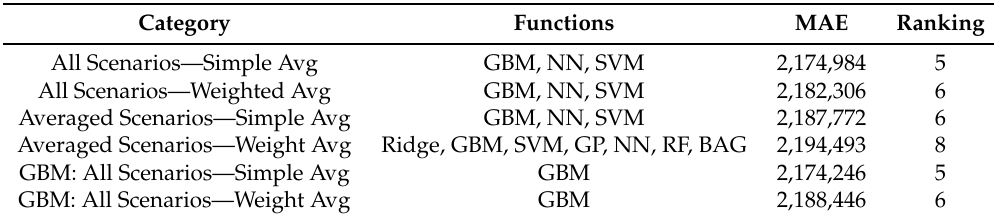
Table 7. The performances for ensemble with multiple forecasting machines with adjusted means and STDs (standard deviations) are measured by the MAE in Wh/m 2 . Category Functions MAE